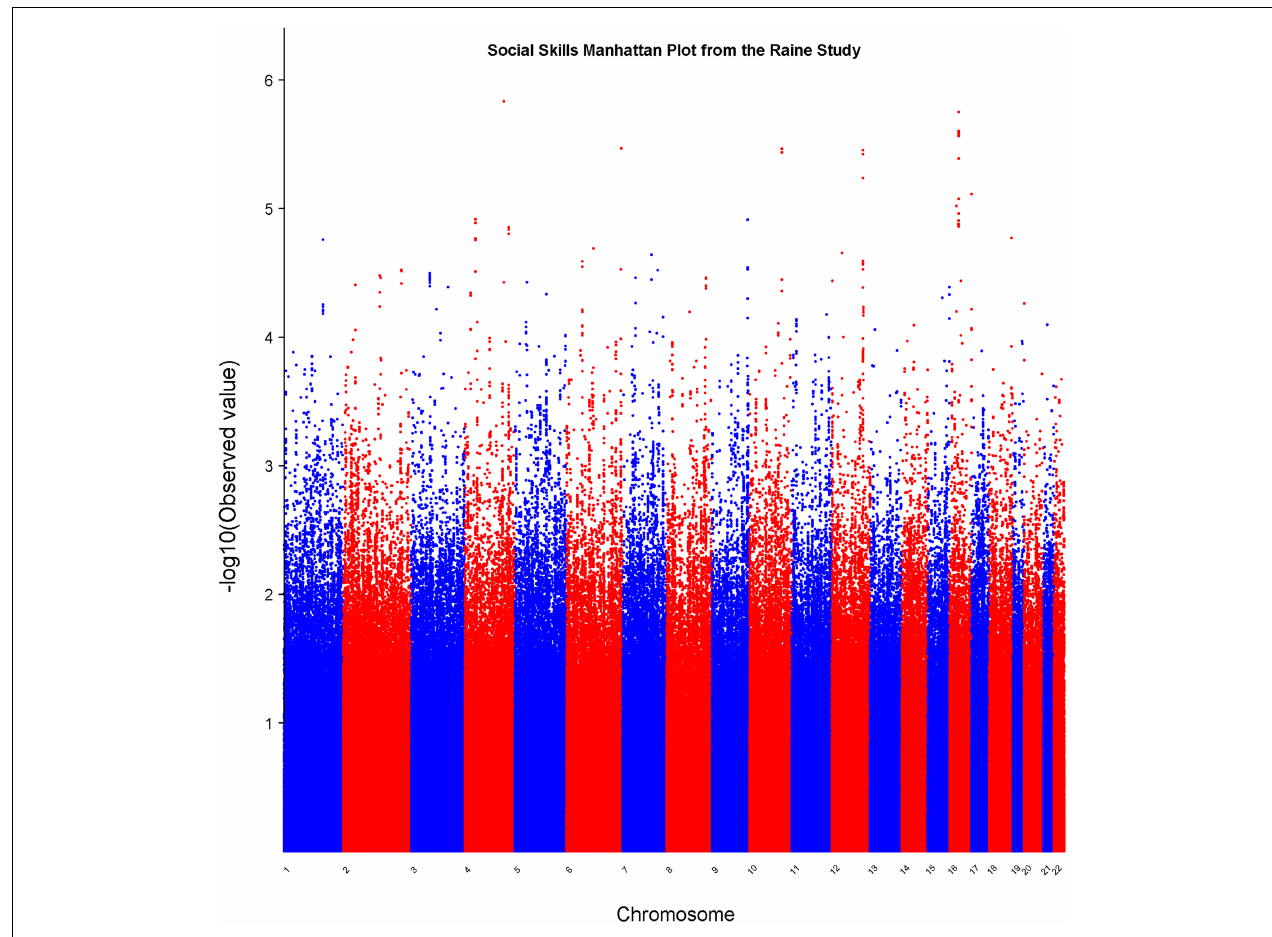
FIGURE 3 | Manhattan plot for social skills . Statistical significance of each SNP on the − log10 scale as a function of the chromosome position.